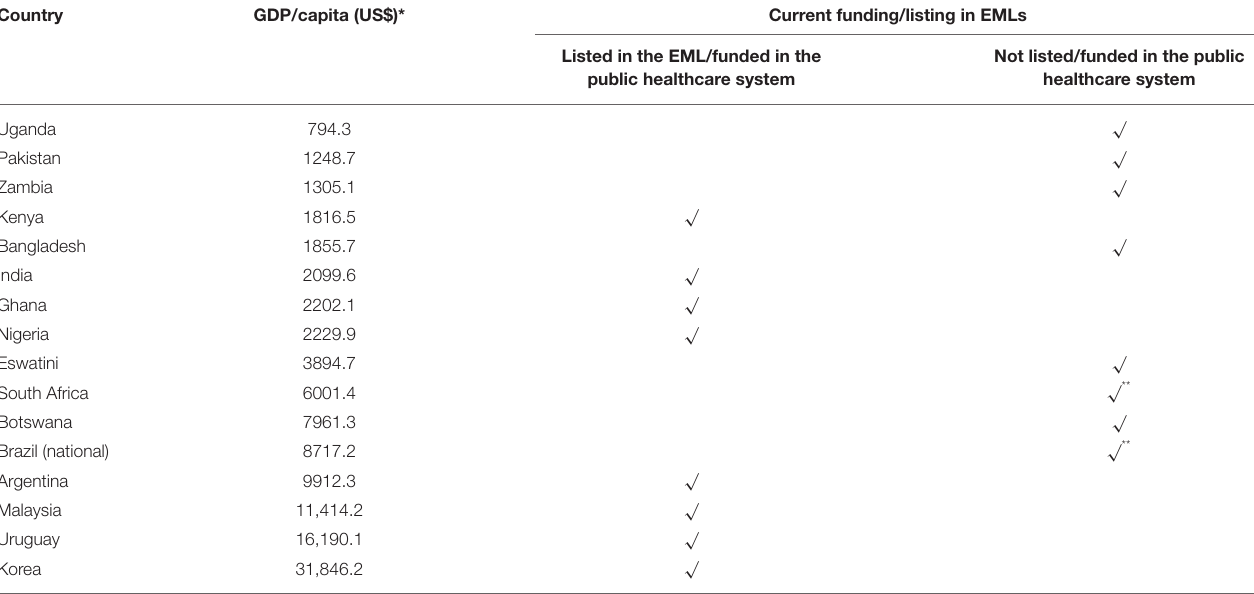
TABLE 1 | Current GDP/capita and listing of long-acting insulins in country EMLs/funding among the studied countries across Africa, Asia, and South America. Country GDP/capita (US$)*